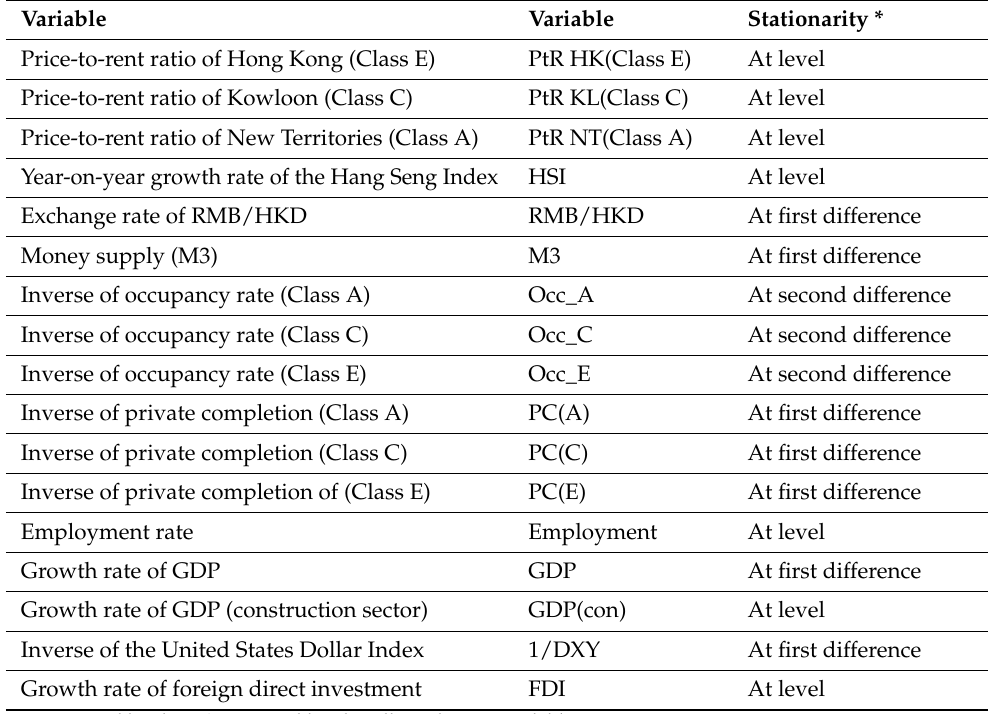
Table 2. Results of ADF